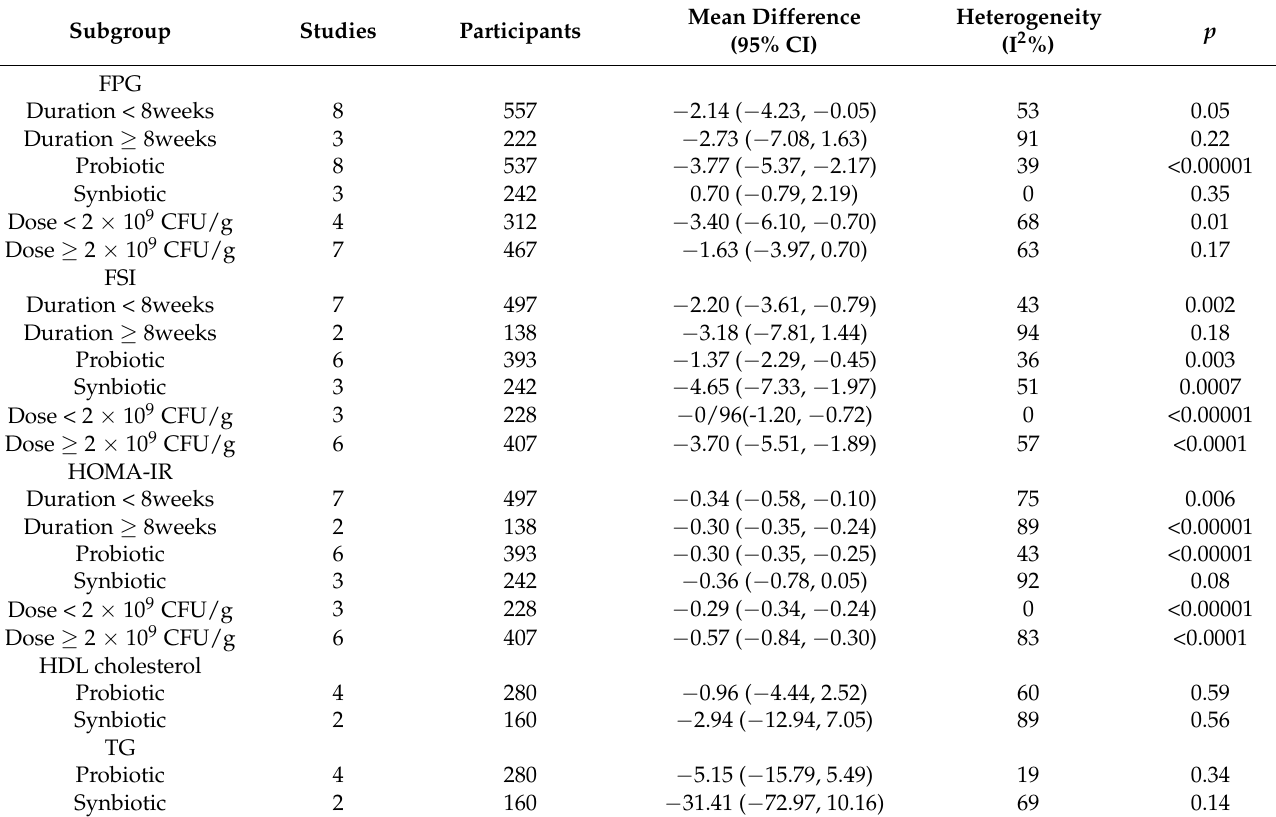
Table 3. The results of subgroup analysis according to duration, intervention type, and